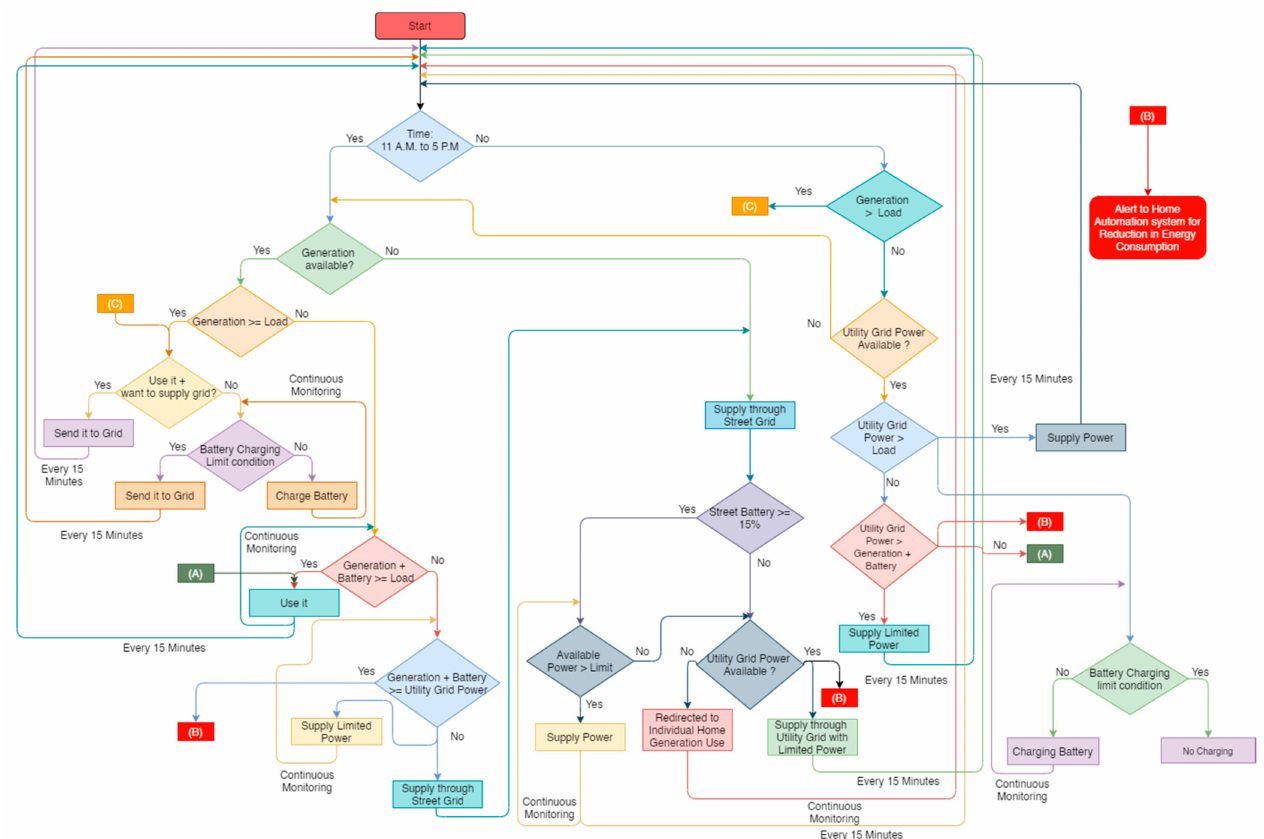
Figure 3. Electrical Energy Flow Algorithm for